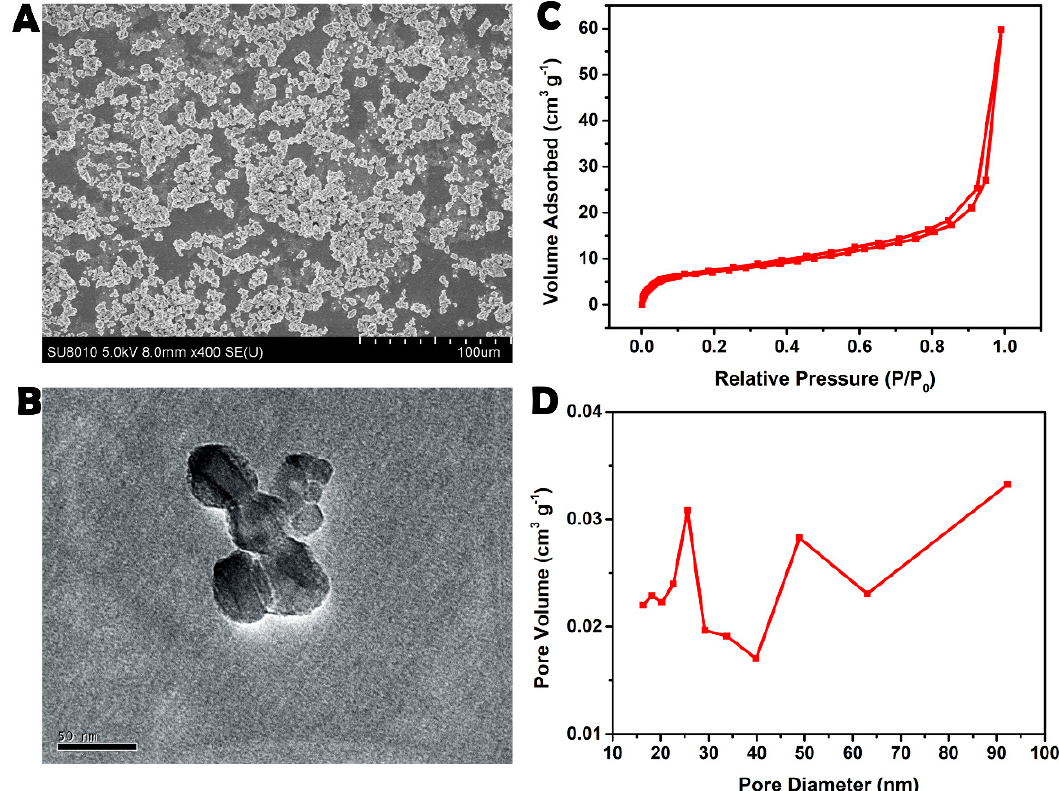
Figure 1. SEM image ( A ), TEM image ( B ), nitrogen adsorption-desorption isotherms ( C ) and their corresponding pore size distribution curve ( D ) of magnesium oxide nanoparticles (MgONPs).